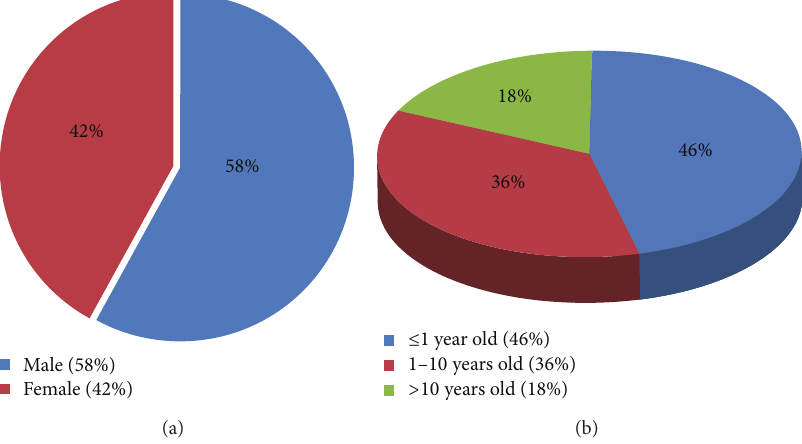
Figure 8: Charts to show (a) incidence according to sex and (b) incidence according to age of malignant ectomesenchymoma.